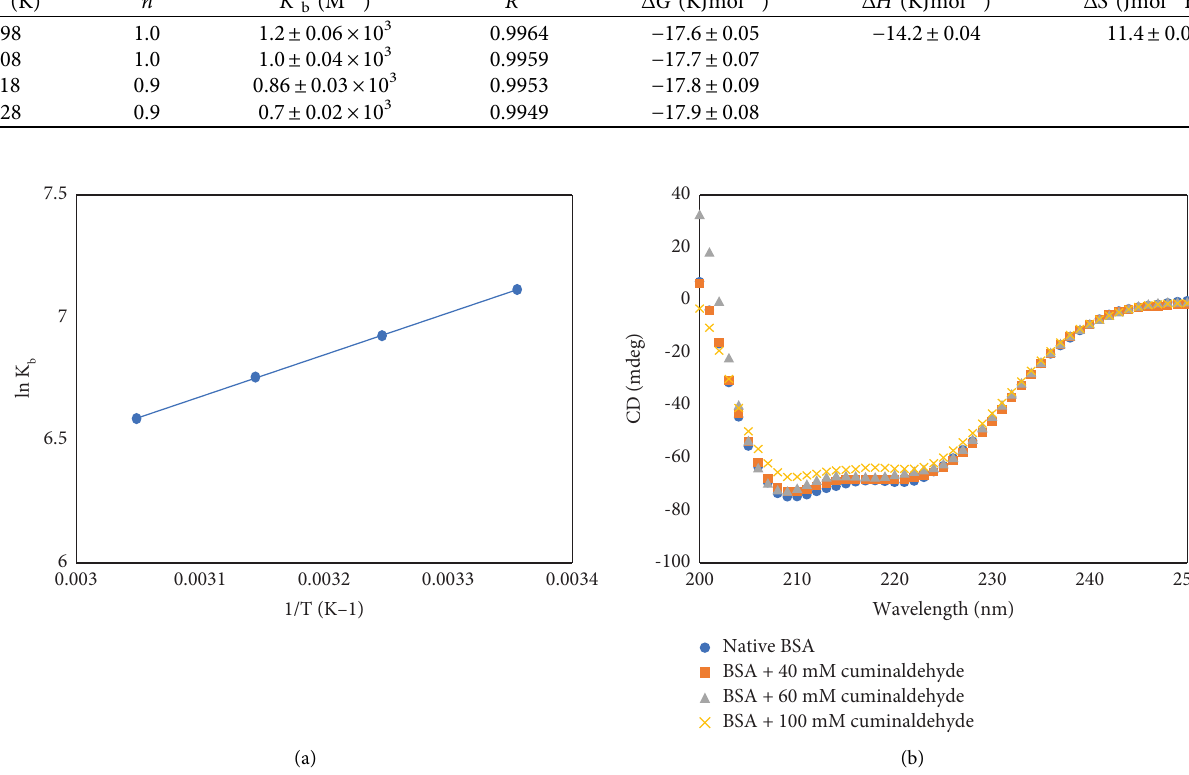
Figure 4: (a) Van’t Hof plots at three temperatures obtained using K b for the BSA–cuminaldehyde interaction measured by fuorescence quenching. (b) Far-UV CD spectra of BSA in the absence and presence of various concentrations of cuminaldehyde at 25 ° C in 20mM tris bufer of pH 7.4.